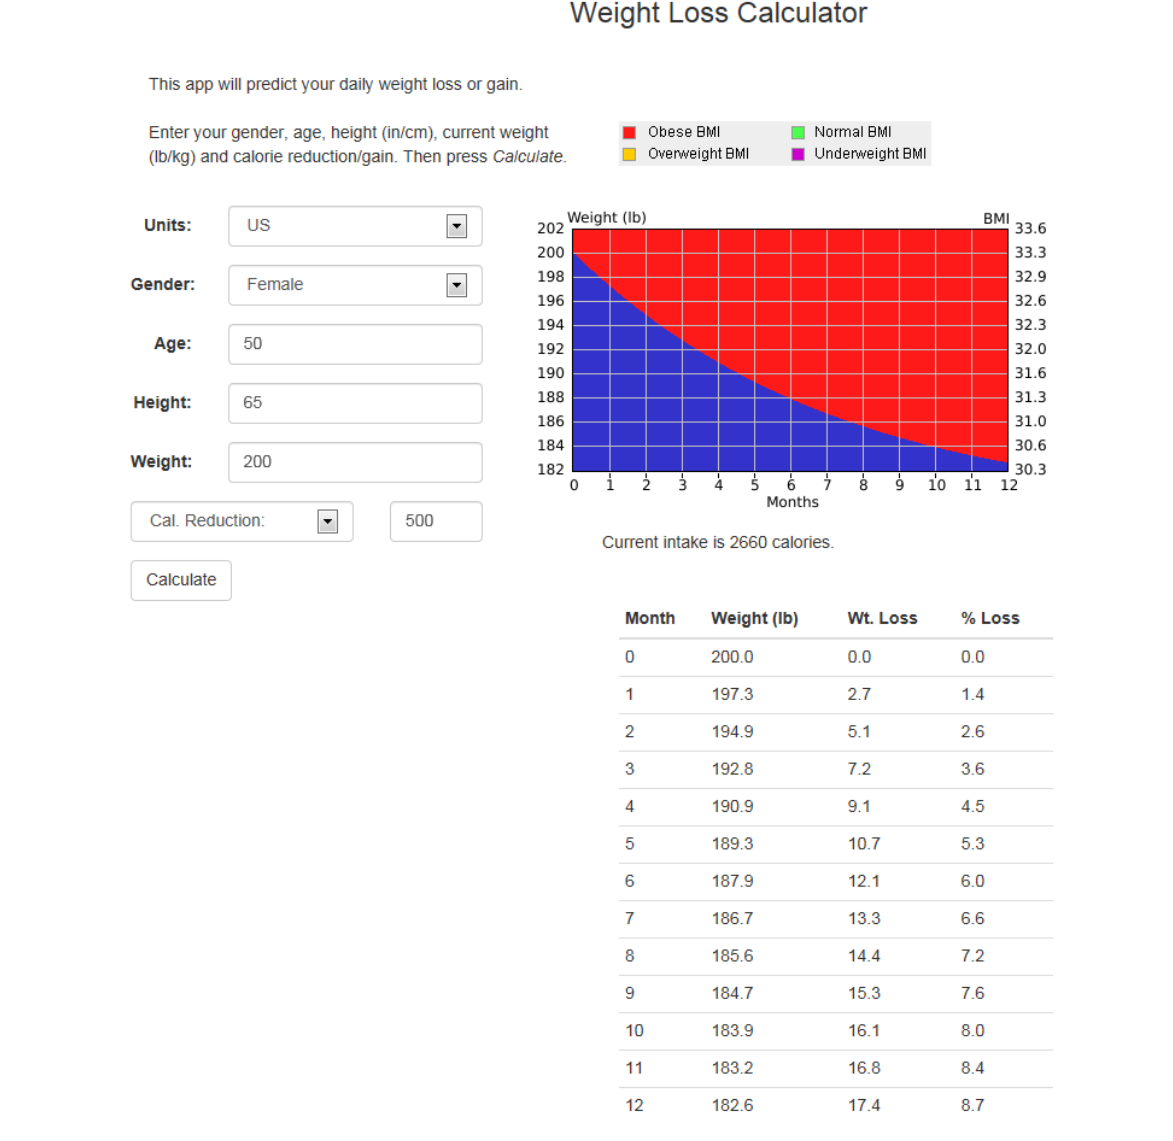
Figure 1. Predicted weight change based on mathematical models of energy balance and an energy intake target that reduces intake by 500 kcal/day. This example was created at http://weight-loss-predictor.appspot.com/weight for a hypothetical 50-year-old female who is 65 inches tall, weighs 200 pounds, and wishes to reduce her intake by 500 kcal/day, which would result in weight loss of 17.4 pounds or 8.7% over 12 months if adherent to the new energy intake